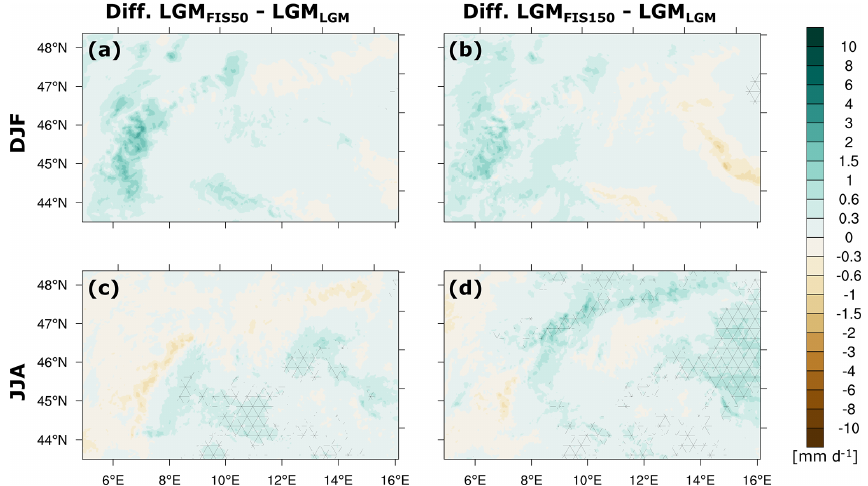
Figure 7. Differences in climatological mean values of daily precipitation intensity over the Alps for (a, b) winter (DJF) and (c, d) summer (JJA): (a, c) LGM FIS50 minus LGM LGM and (b, d) LGM FIS150 minus LGM LGM . Crosshatched areas indicate statistically significant differences at a significance level of 0.05 (using a two-tailed bootstrapping